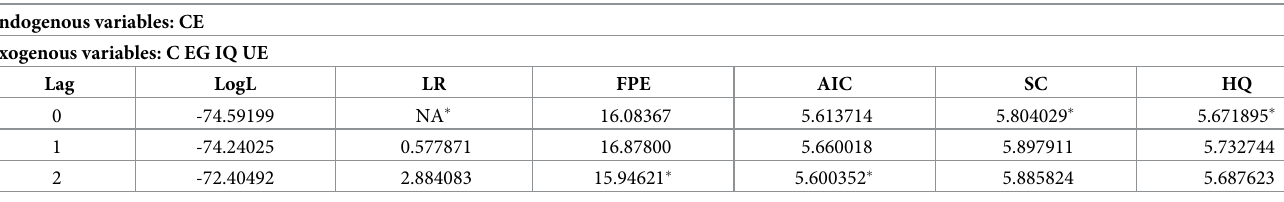
Table 3. VAR lag order selection